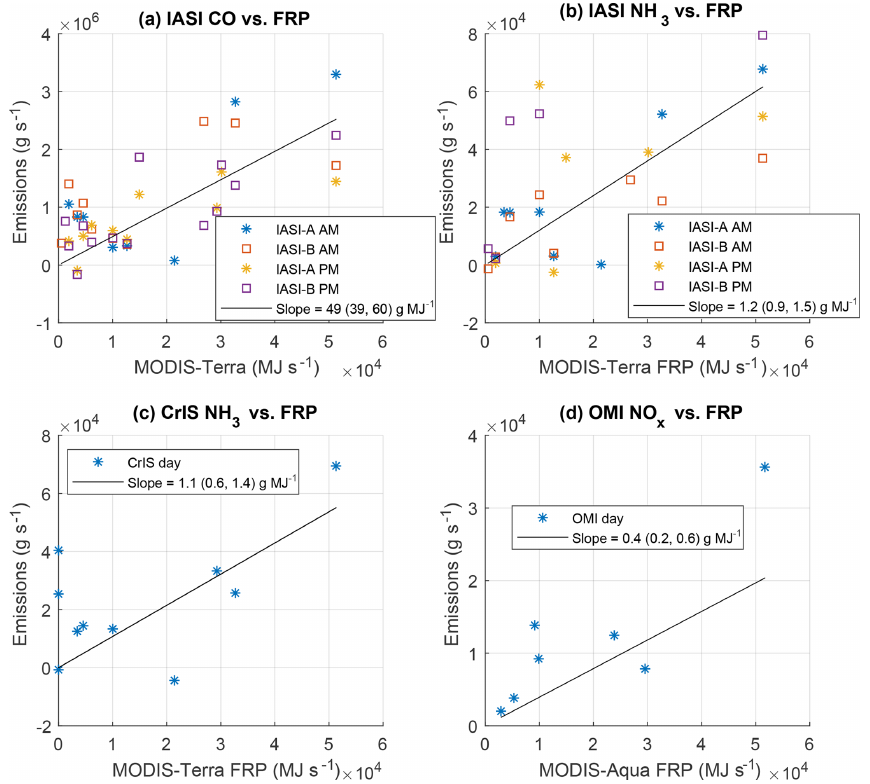
Figure 10. Scatter plot of daily emissions versus MODIS FRP for (a) IASI CO, (b) IASI NH 3 , (c) CrIS NH 3 , and (d) OMI NO x . The slope and 95% confidence interval of a linear fit constrained to go through the origin are also